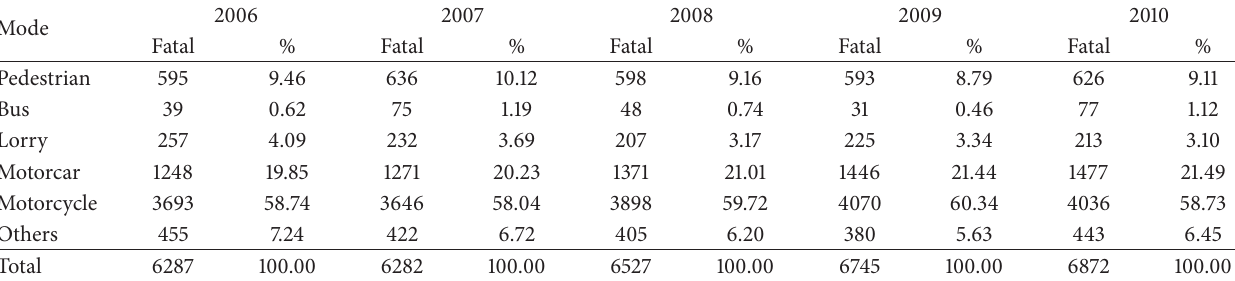
Table 1: Fatality percentage by mode of transport in Malaysia.